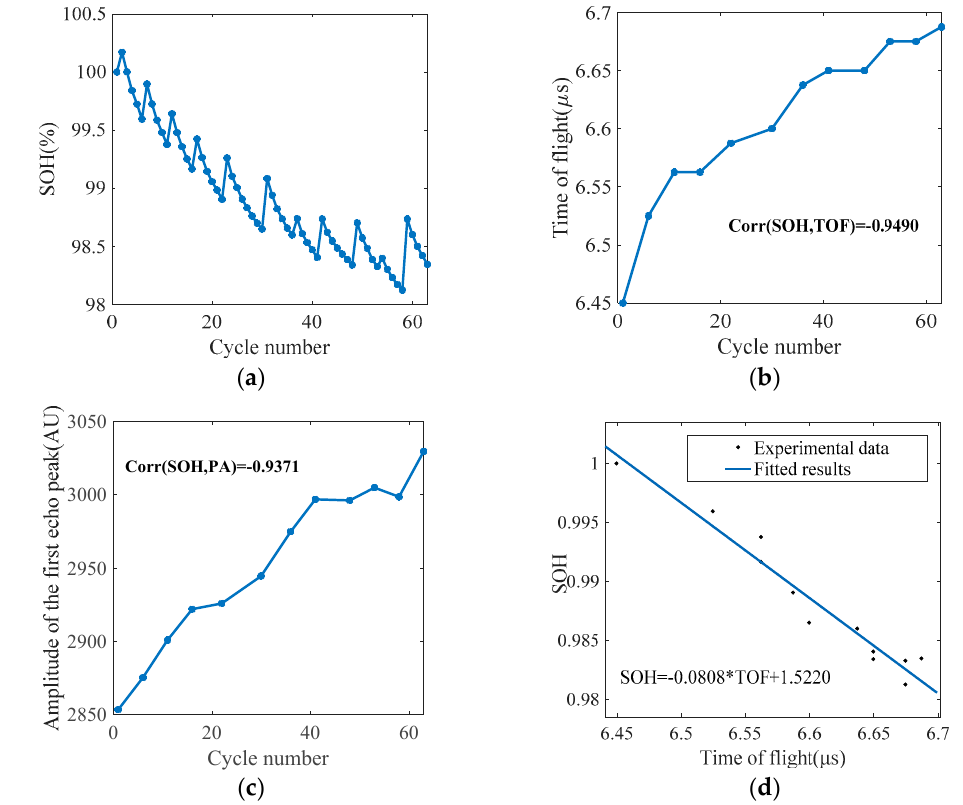
Figure 4. Cycling test results for battery A2: ( a ) cycling performance, ( b ) time-of-flight, ( c ) amplitude of the first echo peak, and ( d ) plot of SOH as a function of TOF.